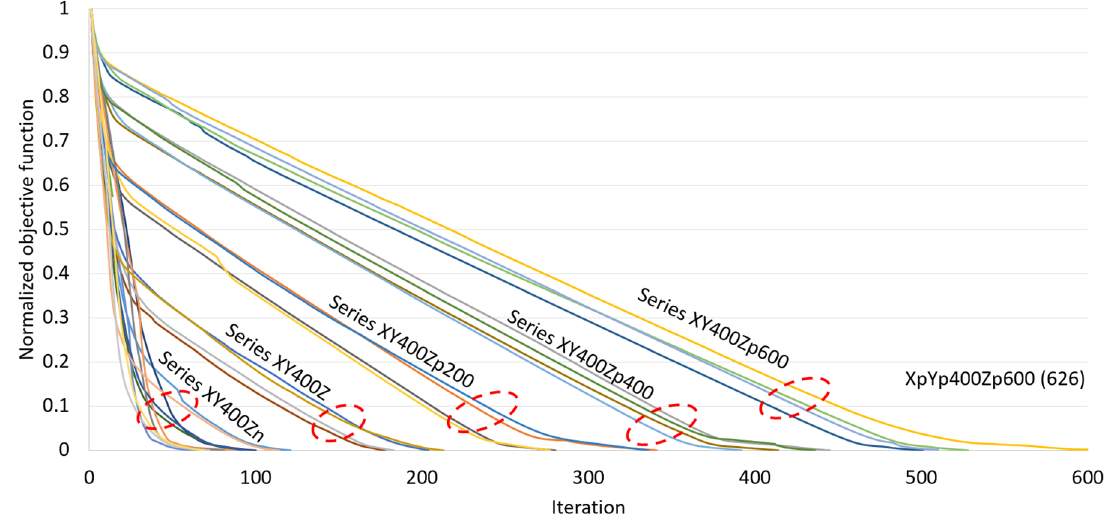
Figure 14. Convergence history for 28 shape change analysis cases in the tri ‐ directional mode for series XY400 for SB2.